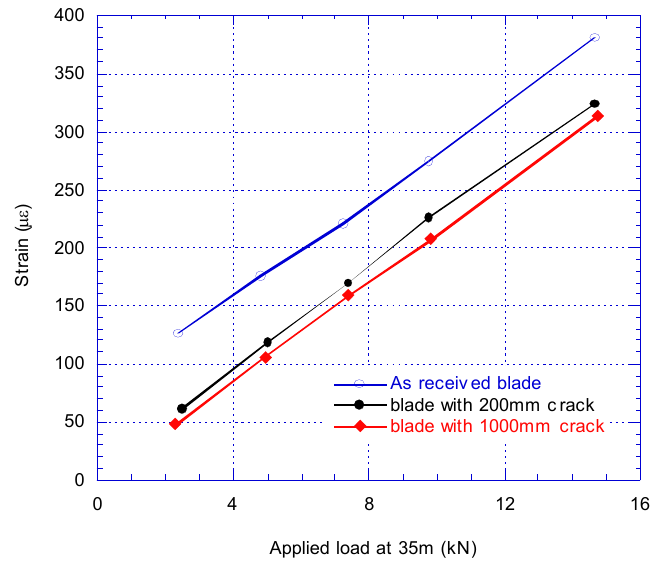
Figure 8. Comparison of strain at SG2 before and after introducing 200 mm and 1000 mm crack.